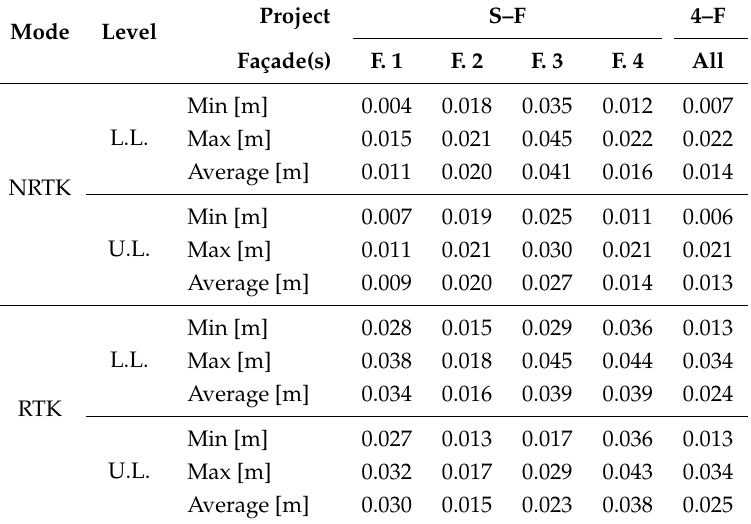
Table 5. Horizontal residuals.